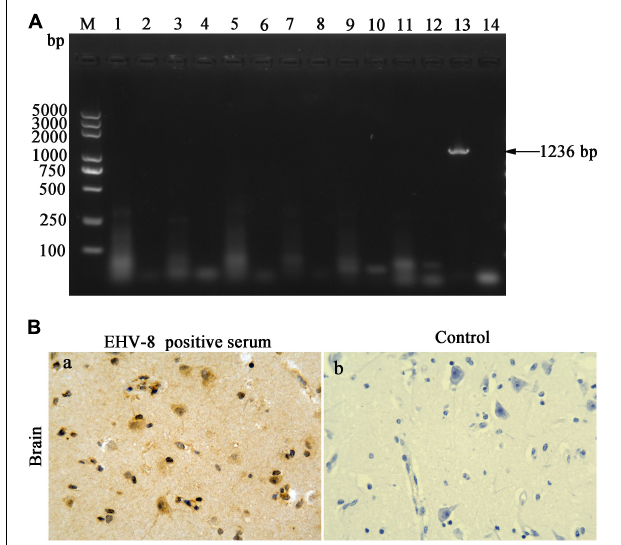
FIGURE 2 | Pathogen identification in the brain. DNA/RNA was extracted from brain tissues; seven pathogens were detected by PCR or RT-PCR (A) . Lane M represents a 5,000-bp DNA molecular weight ladder, 1 represents H3N8 detection of brain tissues, 2 represents negative control of H3N8, 3 represents WNV detection of brain tissues, 4 represents negative control of WNV, 5 represents JEV detection of brain tissues, 6 represents negative control of JEV, 7 represents EAV detection of brain tissues, 8 represents negative control of EAV, 9 represents EHV-1 detection of brain tissues, 10 represents negative control of EHV-1, 11 represents EHV-4 detection of brain tissues, 12 represents negative control of EHV-4, 13 represents EHV-8 detection of brain tissues, and 14 represents negative control of EHV-8. (B) Immunohistochemical detection of EHV-8 in brain section. Treatment of brain tissue using EHV-8-positive serum as primary antibody (a) and negative control brain tissue with mouse IgG substituted for the primary antibody (b) . All images are shown at × 40